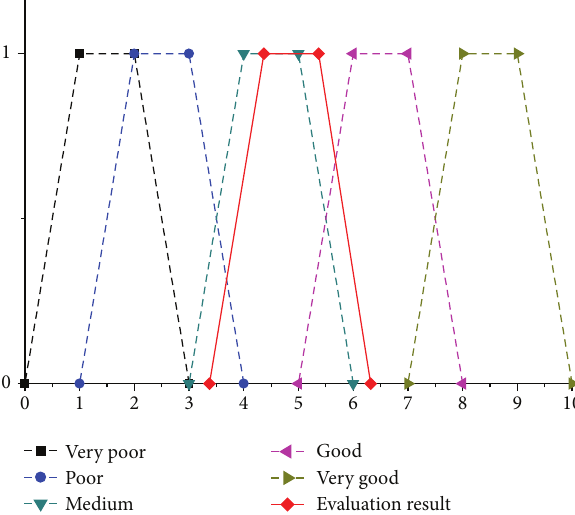
Figure 3: The membership functions of the five grades of the linguistic variables and the evaluation